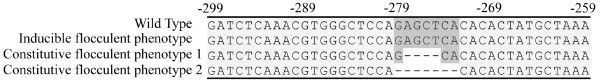
Alignment of the relevant region of the sequenced EPG1 promoter, driving the expression of FLO5 in the recombinant yeast, with the original EPG1 promoter found in the wild typeK. marxianusstrain. The nucleotide positions upstream of the ATG are presented as negative numbers and the differences between the promoter sequences are shown in grey.